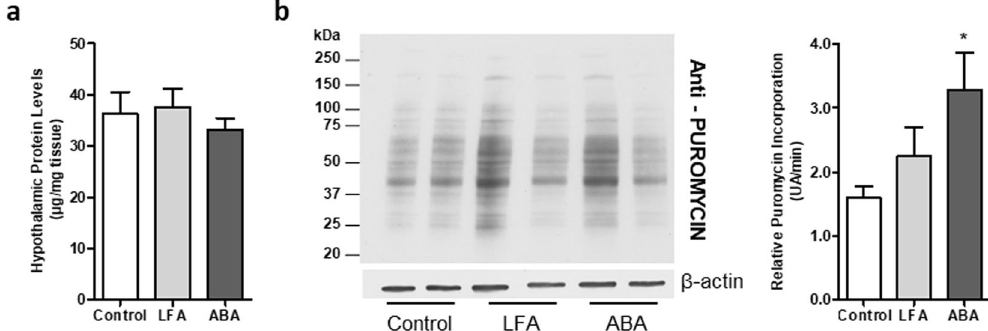
Figure 8. Assessment of protein synthesis using the SUnSET method at day 17. ( a ) Hypothalamic protein content assessed at day 17 in the hypothalamus of Control mice (open bars) or mice with limitation of food access (LFA, grey bars) or activity-based anorexia (ABA, black bars), n = 8/group. ( b ) Representative immunoblots for puromycin and β -actin at day 17 (from 2 individuals/group). Relative puromycin incorporation was expressed as the ratio between puromycin densitometry and time from puromycin injection to tissue sampling (n = 8/group). * p < 0.05 vs